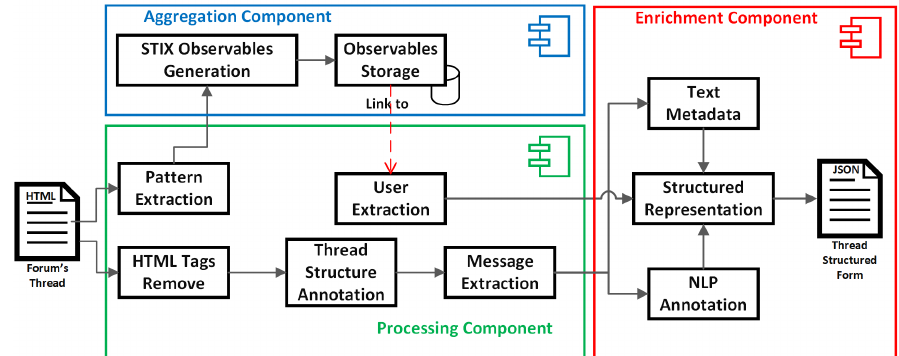
Figure 5. SECDFAN Processing Layer